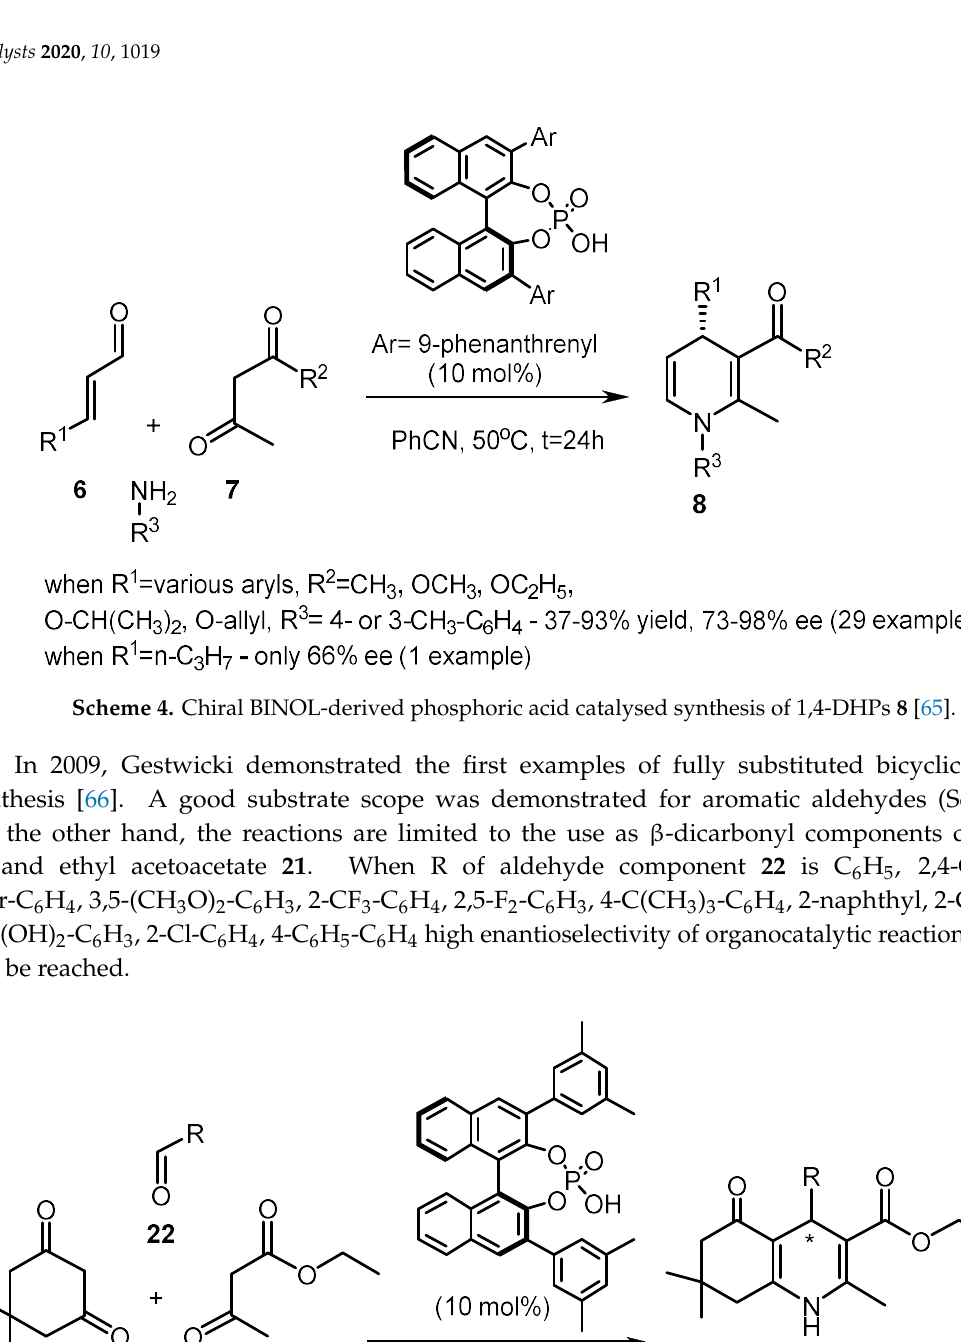
Scheme 5. Chiral BINOL-derived phosphoric acid catalysed synthesis of bicyclic 1,4-DHP 23 [66].